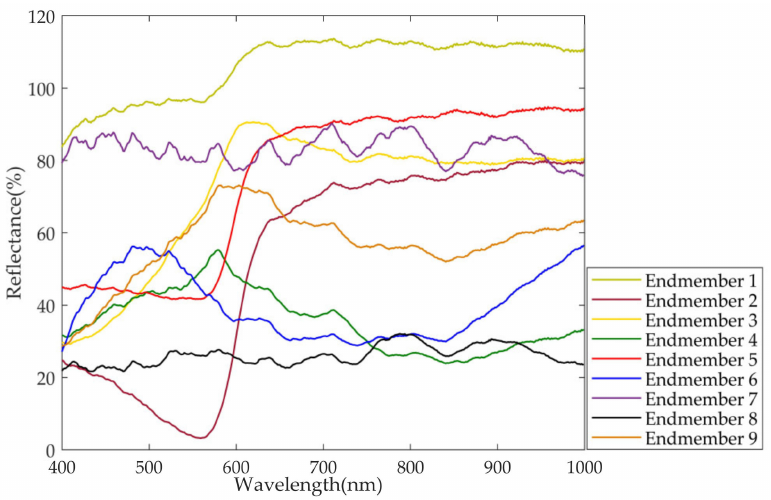
Figure 8. Nine endmember spectral curves for the hyperspectral image of the Chinese painting. Additionally, spectral matching was carried out between the endmember spectra and a pure pigment spectral library constructed by the laboratory. The spectral library contains more than 30 kinds of commonly used painting pigments of red, green, blue, yellow, black and white. The method of SFF, SAM and BE were combined to calculate the similarity between the unknown endmember spectral curves and standard pigment spectral curves. The fitting degree of the three methods was scored, and the final score was obtained with the weights of 0.5, 0.3 and 0.2, respectively. The higher the score, the